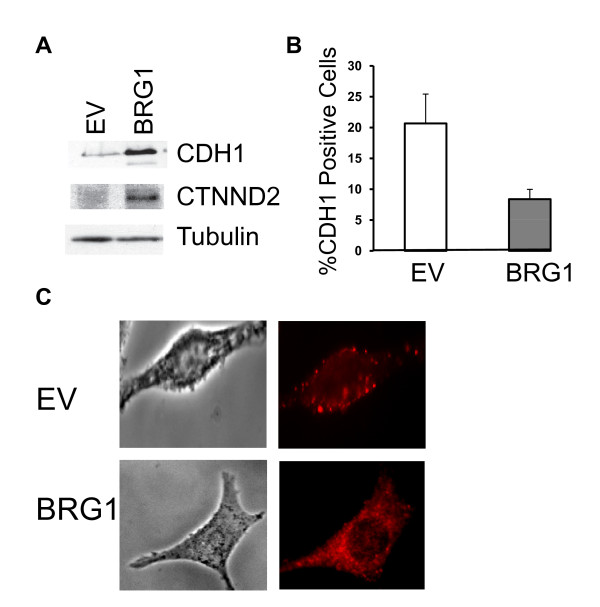
BRG1 promotes E-cadherin expression but compromises E-cadherin localization to the cell junction in SK-MEL5 cells. A. Detection of E-cadherin (CDH1) and CTNND2 protein expression by Western blotting. Tubulin is a loading control. B. Cells were stained with control IgG or an antibody to E-cadherin and FITC labeled secondary antibody. E-cadherin at the cell surface was quantified by FACS analysis. Significantly less E-cadherin was localized to the cell surface in SK-MEL5 +BRG1 cells compared to control SK-MEL5 cells (p < 0.05). C. E-cadherin staining of representative control SK-MEL5 cells and BRG1 expressing SK-MEL5 cells by immunofluorescence.